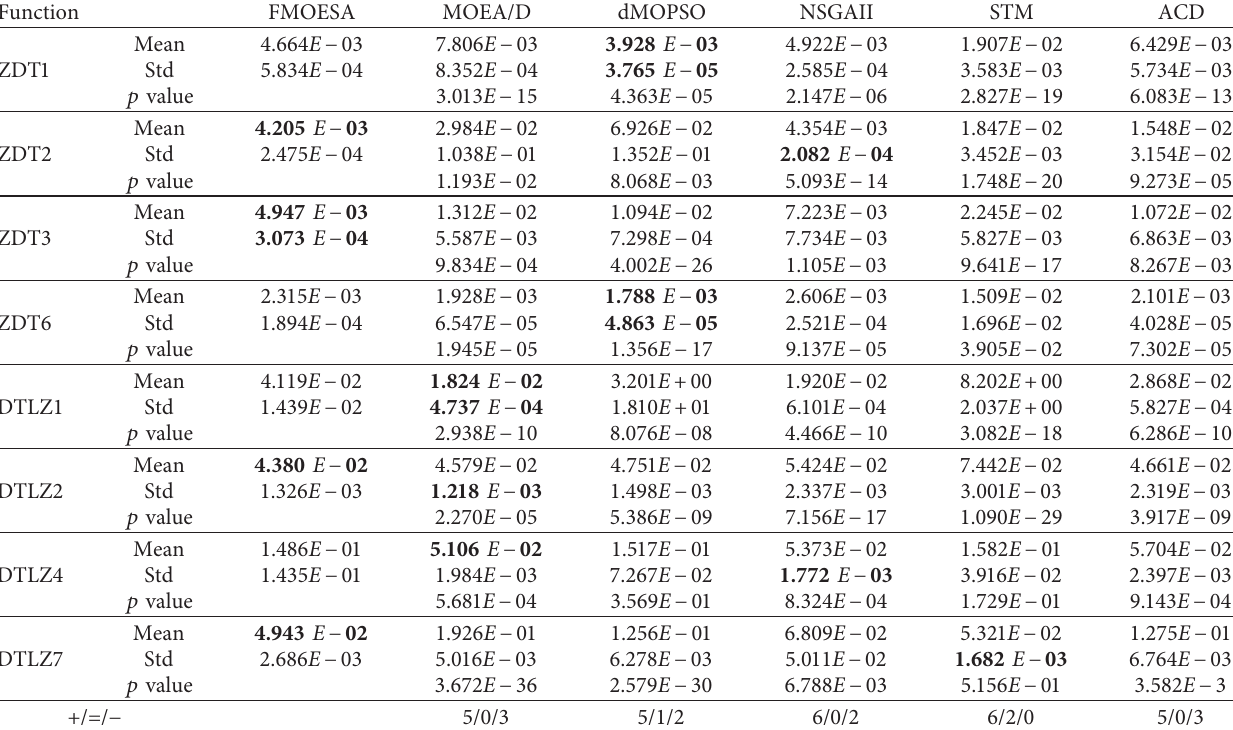
Table 2: IGD results on the eight problems.